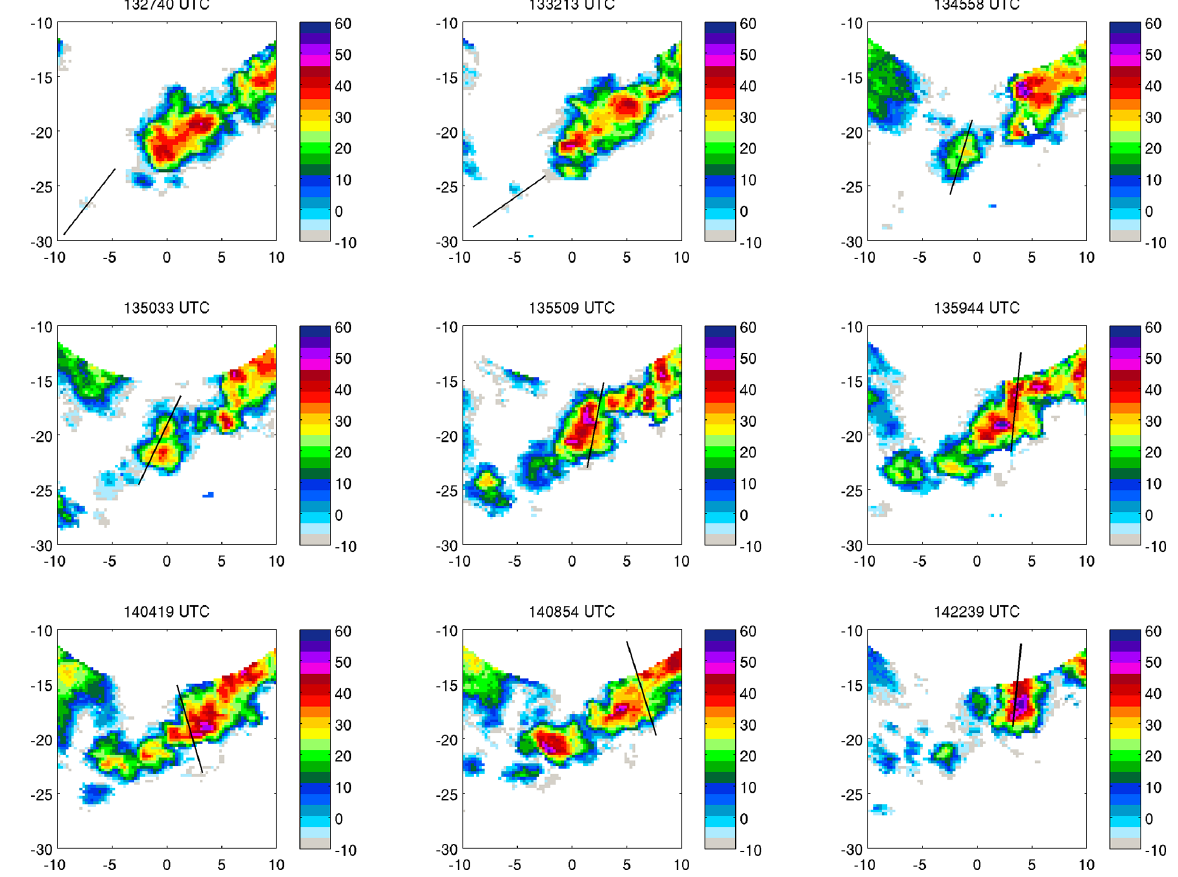
Figure 11. Radar reflectivity at 3.5km altitude, measured by the NCAS precipitation radar during each of the runs shown in Fig. 7. The x and y axes are a Cartesian grid, showing kilometres east and west of the radar site, and the colour scale is in units of dBZ; 1min of flight track is shown for each